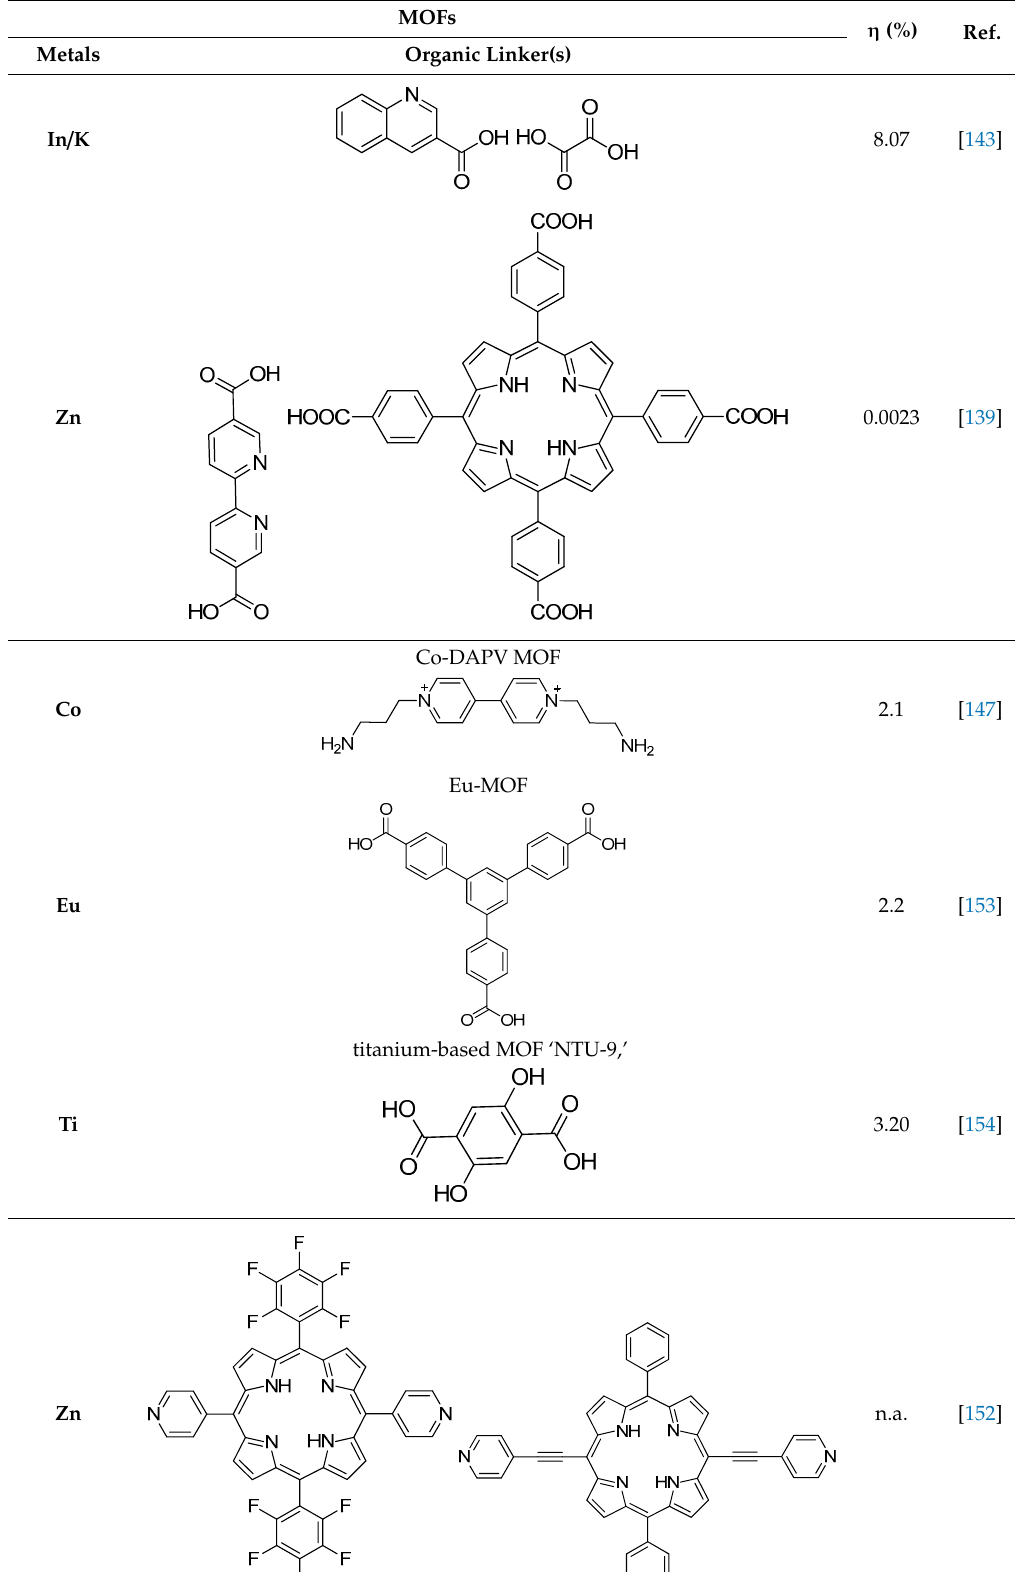
Table 2. MOFs effectively employed as sensitizers in DSSC. For sake of brevity, we prefer to report the metal and the organic linker separately. The reported values of photoconversion efficiency could not be compared between each ‐ others, yet they could shine light on the potentiality of this class of material.